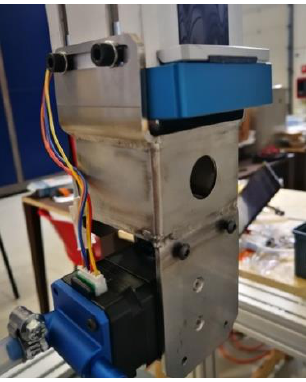
Figure 5. Fused Deposition Modeling (FDM) head of PEEK extrusion machine.